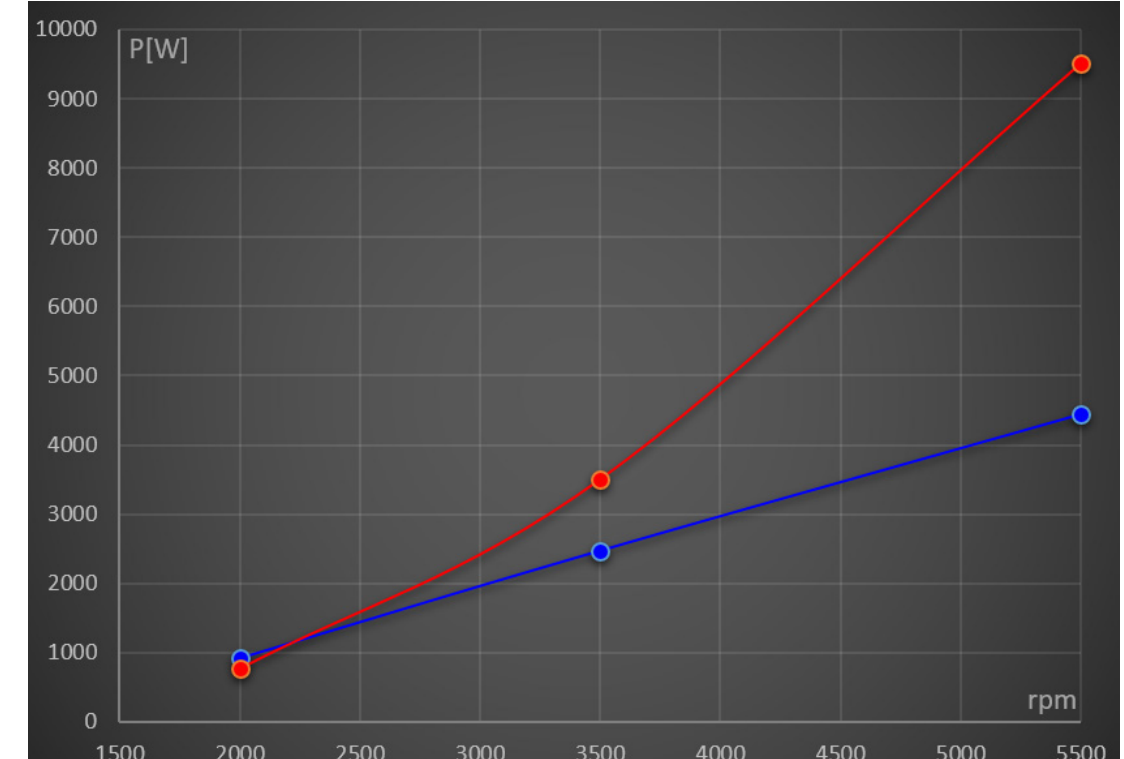
Figure 10. Turbine (orange) and compressor (blue) power in function of ICE RPMs.